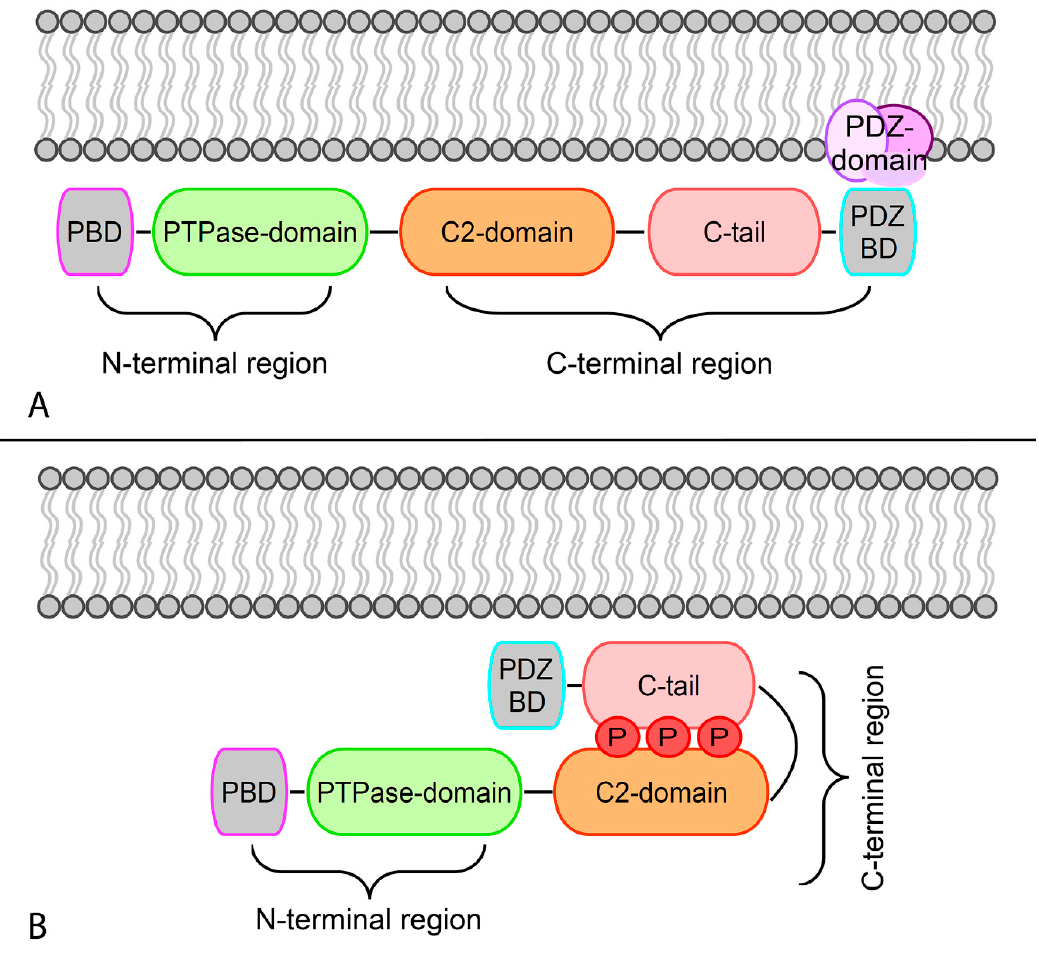
Figure 1. Schematic representation of the open and closed conformations of phosphatase and tensin homolog (PTEN) based on its phosphorylation status. ( A ) Dephosphorylation leads to the open conformation that allows PTEN to associate with the membrane. The association of PTEN with the negatively charged membrane occurs through electrostatic interactions. ( B ) Binding of the C2 domain to phosphatidylserine leads to a conformational change and activation of the phosphatase C-tail